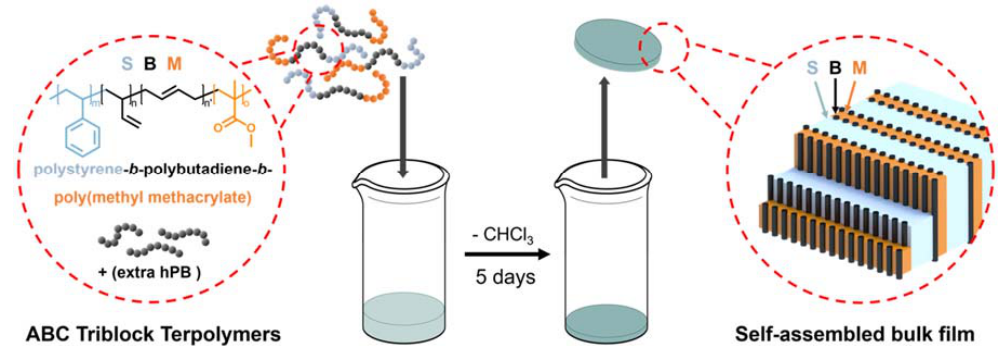
Scheme 1. Preparation of SBM / B bulk films. Chemical structure of SBM, casting of the bulk film and lamellar PS / PMMA morphology and varying PB domain depending on polybutadiene homopolymer (hPB)